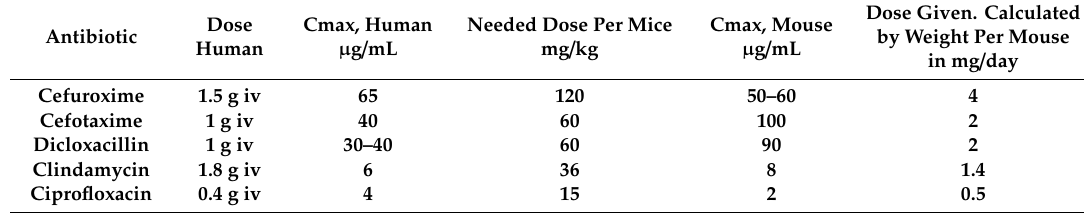
Table 2. Antibiotics used for